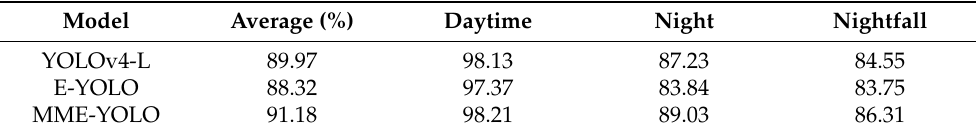
Table 4. Comparison of models on the Road-side Dataset under different lighting conditions. The MME-YOLO is especially suitable for the backlighting conditions at night. Although the low-level edges were overwhelmed by turbulence lighting, the detector can accurately recognize the vehicles on the